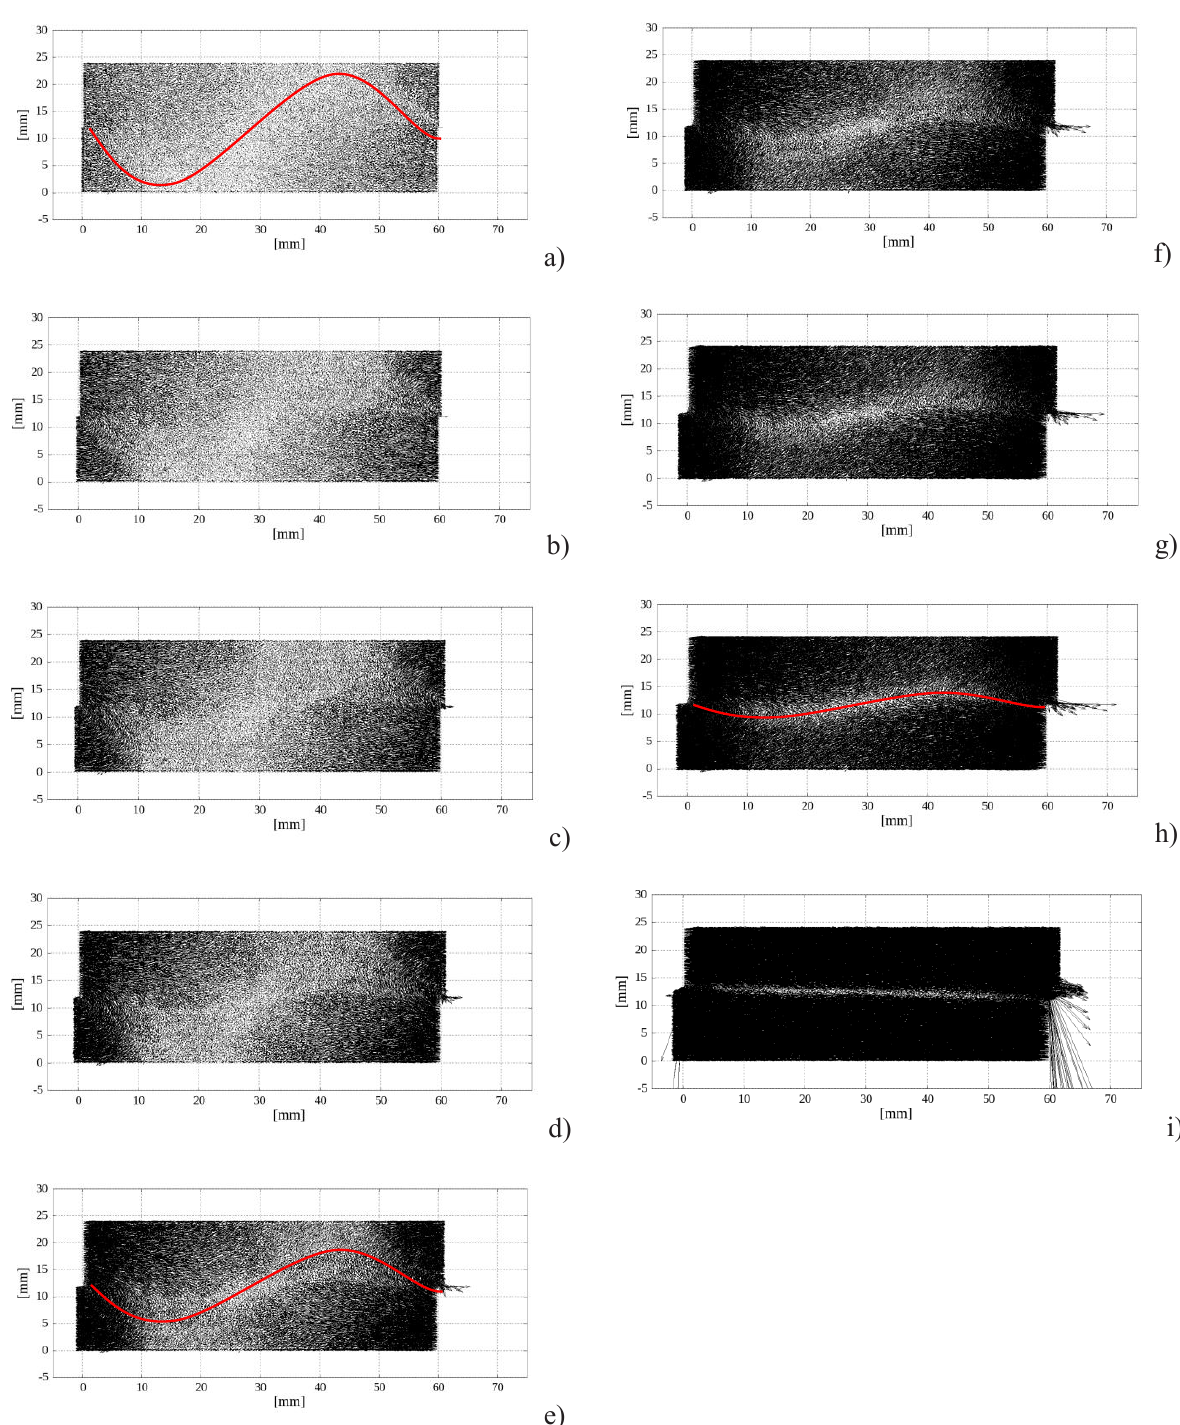
) in the entire specimen for: a) u − i i,avg = 1.75 mm, h) u = 2.00 mm and i) u x x 𝑢⃗ 𝑢⃗